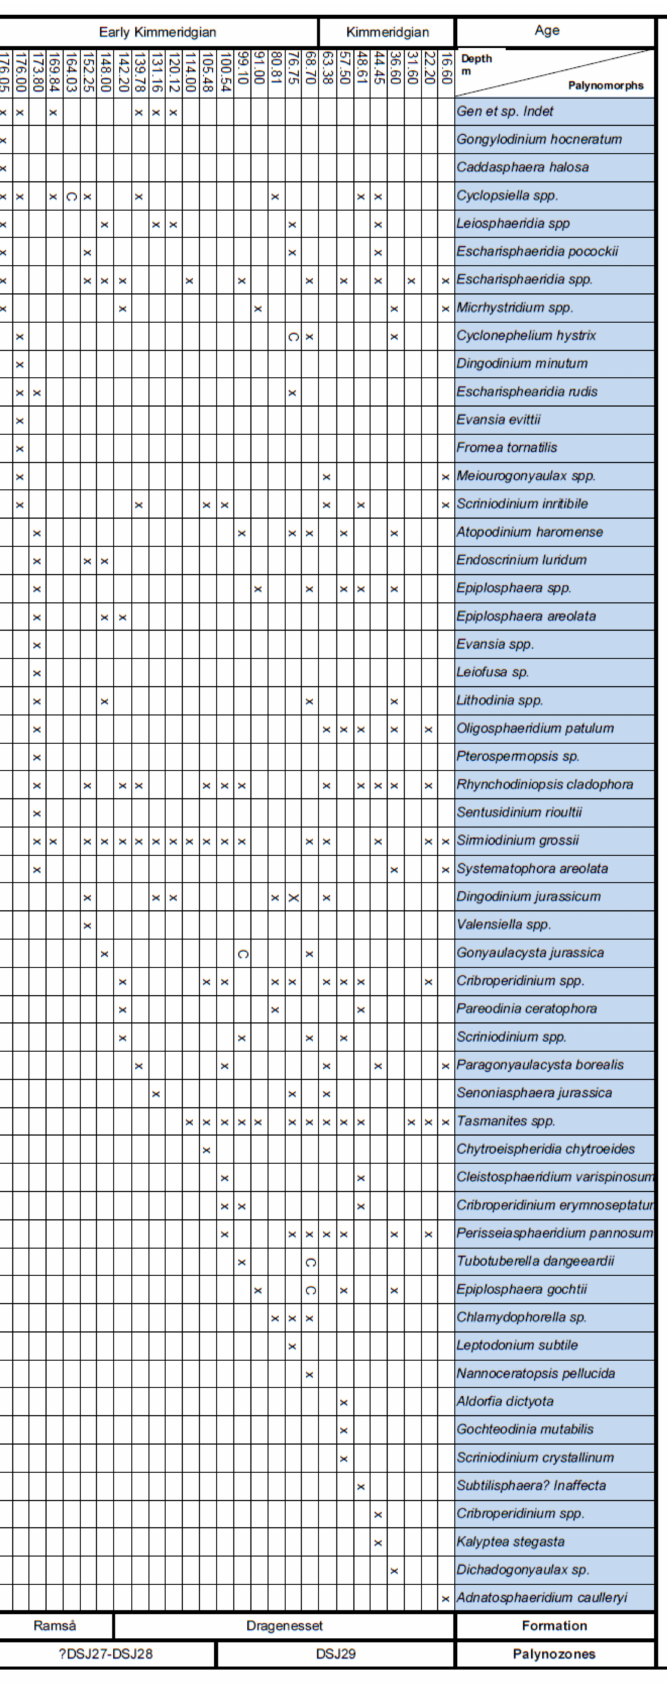
Figure A6. Records of marine palynomorphs in borehole Bh